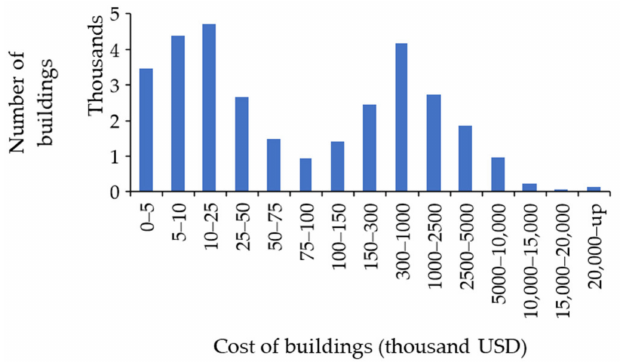
Figure 7. The number of buildings according to construction cost in thousand USD.